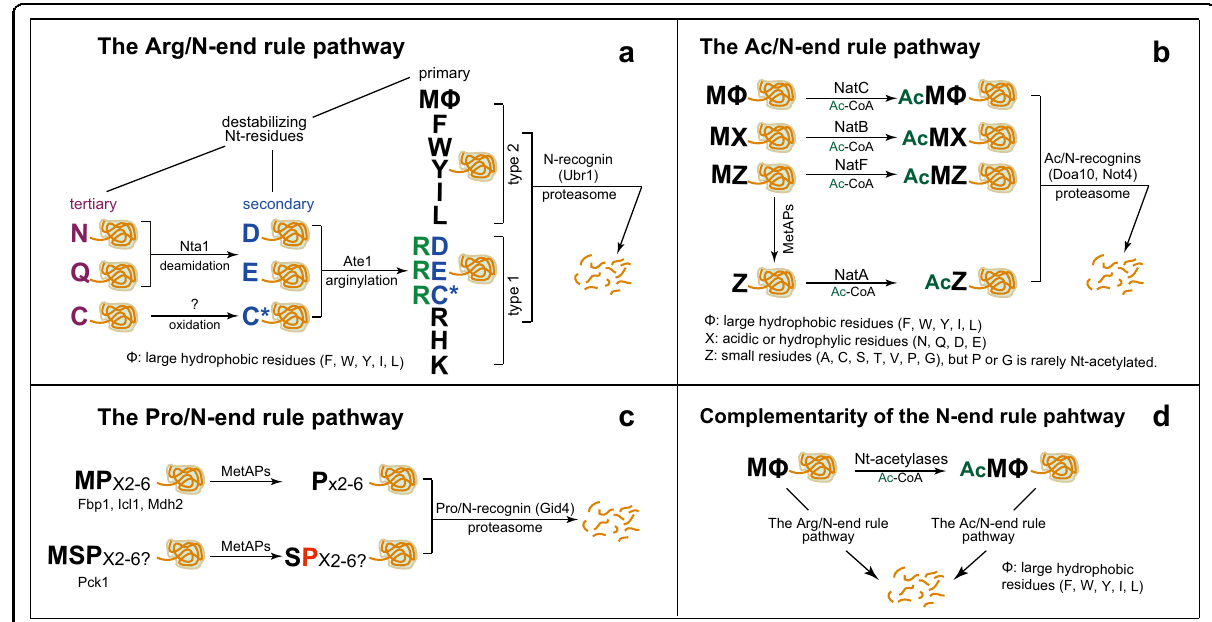
Fig. 1 The N-end rule pathway in S. cerevisiae . a The conventional Arg/N-end rule pathway. Nta1 N-terminal amidase deamidates tertiary destabilizing N-terminal residues Asn and Gln into secondary destabilizing N-terminal residues Asp and Glu, respectively. Subsequently, Ate1 arginyl- transferase attaches Arg to the N-terminal Asp or Glu. Eventually, Ubr1 recognizes the type-1 or type-2 primary destabilizing N-terminal residues of the target substrates for polyubiquitylation and subsequent proteasomal degradation. Note that the N-terminal Cys oxidation-dependent degradation pathway has not yet been established in yeast. b The Ac/N-end rule pathway. Met aminopeptidases (MetAPs) remove the N-terminal initiator Met (iMet), if the residues smaller than Val occupy the penultimate position. NatA, NatB, or NatC Nt-acetylates target proteins largely based on their fi rst two residues. The Ac/N-recognins (Doa10 and Not4) speci fi cally recognize the N-terminal acetyl moiety of the N-terminally acetylated proteins for polyubiquitin-mediated and proteasome-dependent degradation. c The Pro/N-end rule pathway. N-terminal Pro or N-terminal Ser with Pro at position 2 can work as Pro/N-degrons for Pro/N-recognin Gid4 in the GID Ub ligase complex. d Functional and mechanical interplay between the two branches of the N-end rule